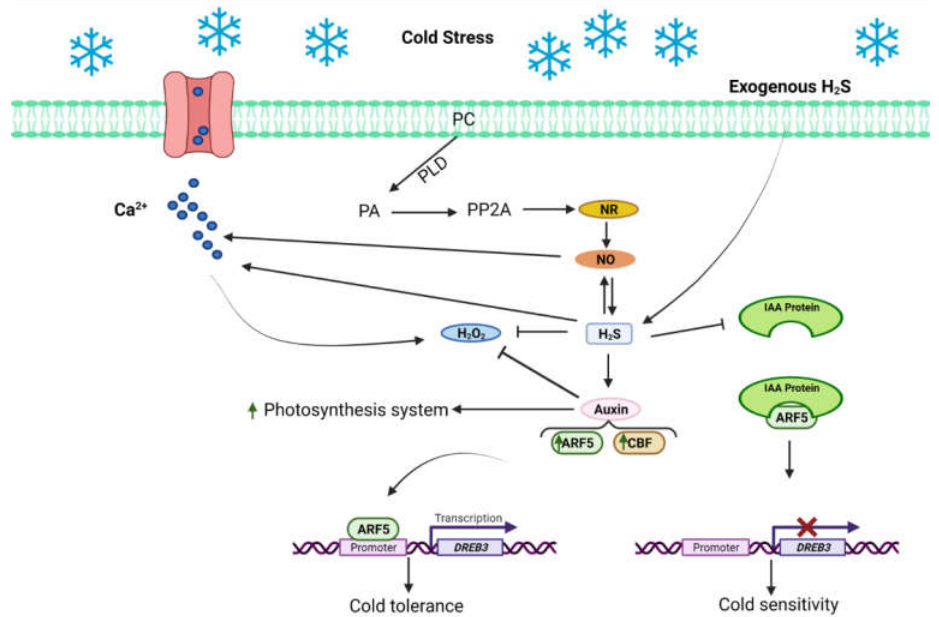
Figure 6. A regulatory model elucidates the role of hydrogen sulfide (H 2 S) in mediating the cold stress response in plants via auxin signaling. In the presence of cold stress, the phospholipase D (PLD) is activated and degrades the phosphatidylcholine (PC) phospholipid of the cell membrane. As a result, phosphatidic acid (PA) is produced, which further regulates protein phosphatase 2A (PP2A), nitrate reductase (NR), nitric oxide (NO), and finally H 2 S. In the absence of H 2 S, auxin distribution, photosynthesis, and carbon assimilation are inhibited in plants under exposure to cold stress. The exogenous application or endogenous H 2 S mediate auxin redistribution in plants and activate the antioxidant defense system along with improved photosynthesis to restore the normal function of the plant at physiological levels. On the other hand, C-repeat binding factors (CBFs) and ARF (auxin-responsive proteins) promote the dehydration-responsive element-binding (DREB) and other related proteins to promote cold tolerance at molecular levels under H 2 S-mediated